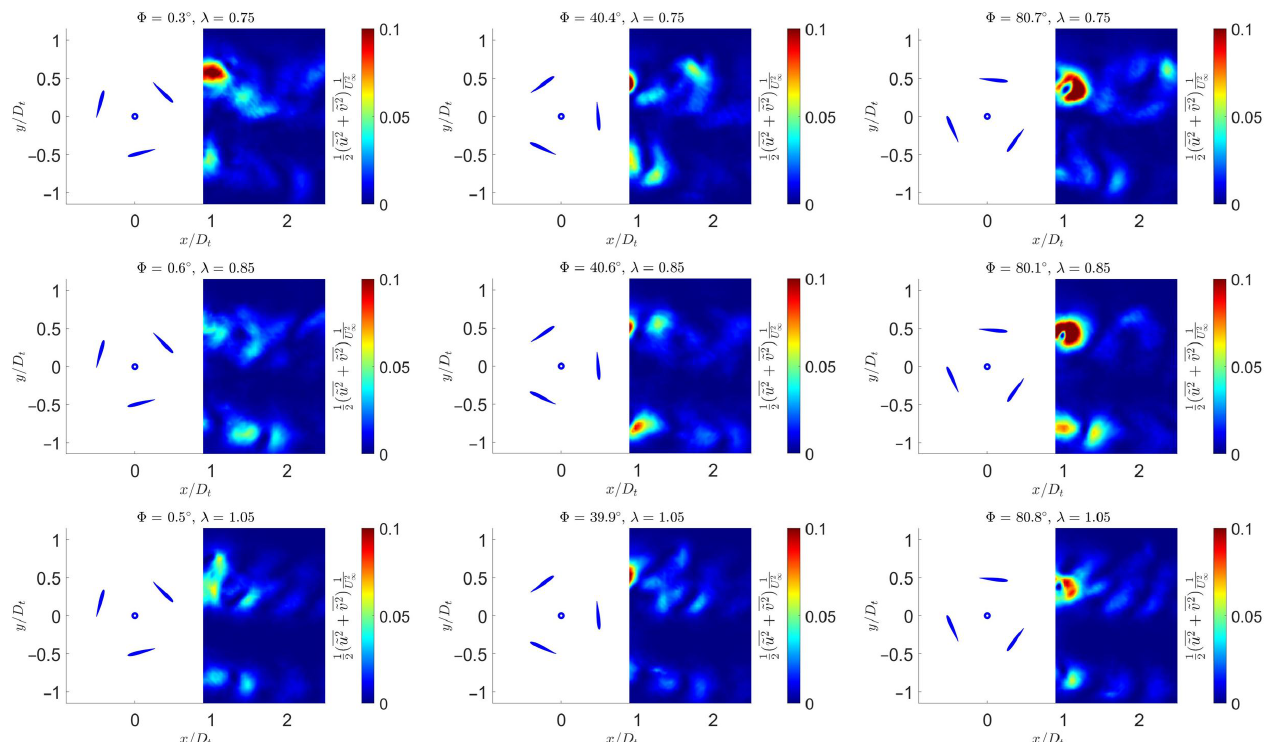
Figure 16. The fluctuating component of the phase-averaged kinetic energy of the flow behind turbine T2 at various phase angles and tip–speed ratios. The blue circle displays turbine T2 rotation center.